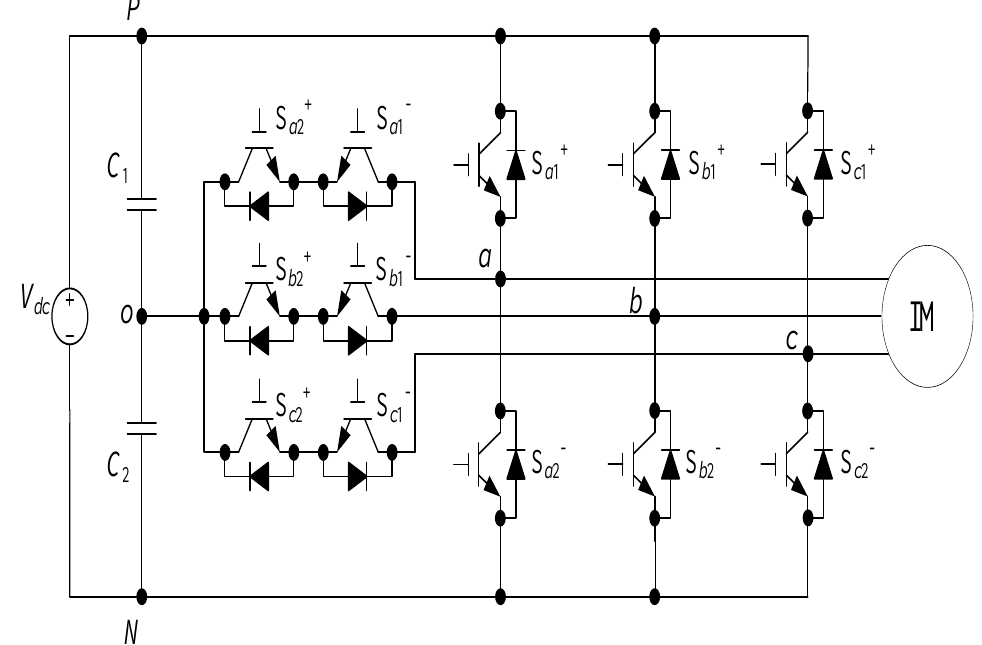
Figure 2. The three-level T-type inverter Figure 2. The three − level T − type inverter architecture.